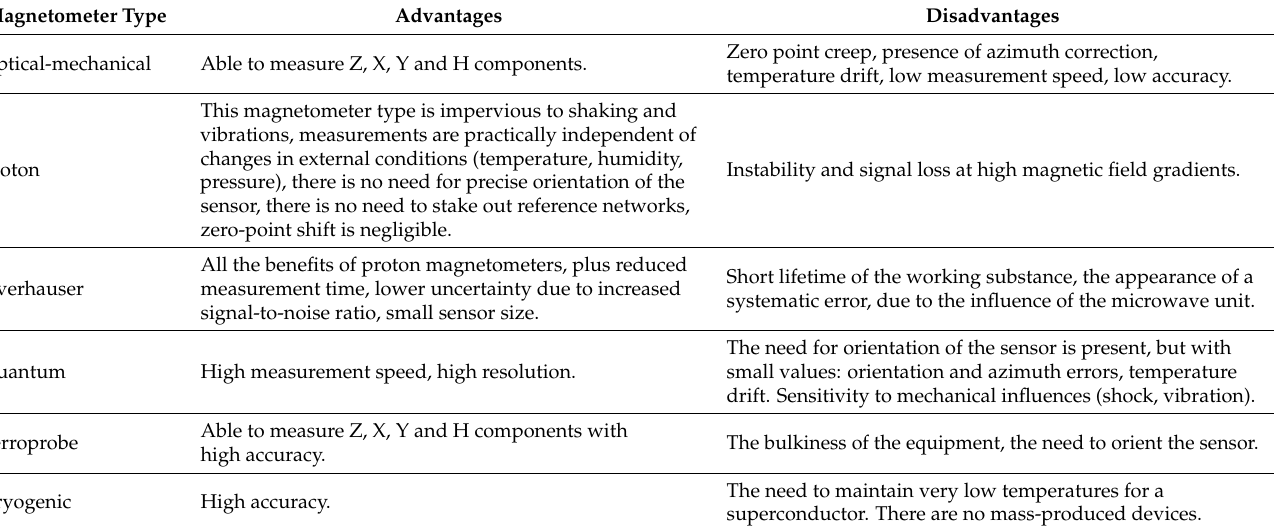
Table 2. Comparative characteristics of various types of